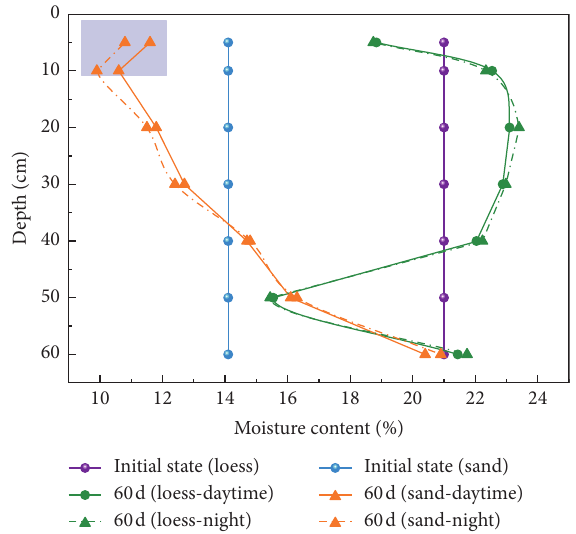
Figure 13: Comparison of moisture content distribution between loess and